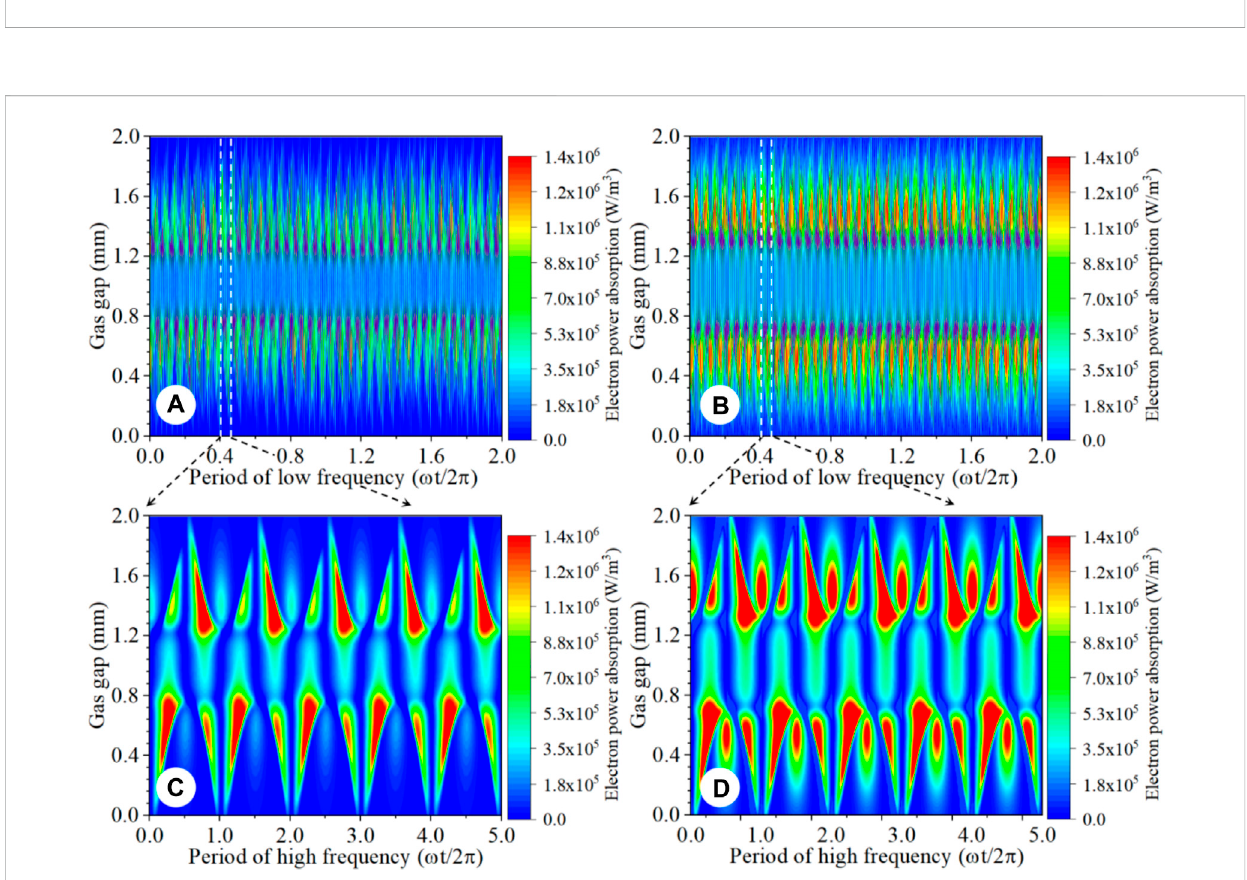
FIGURE 7 Spatio-temporal pro fi le of the power absorption in two LF periods, for (A) V L = 100 V/ V H = 250 V and (B) V L = 100 V/ V H = 350 V, respectively. Moreover, (C) and (D) are in fi ve RF periods in the selected regions corresponding to (A) and (B) .